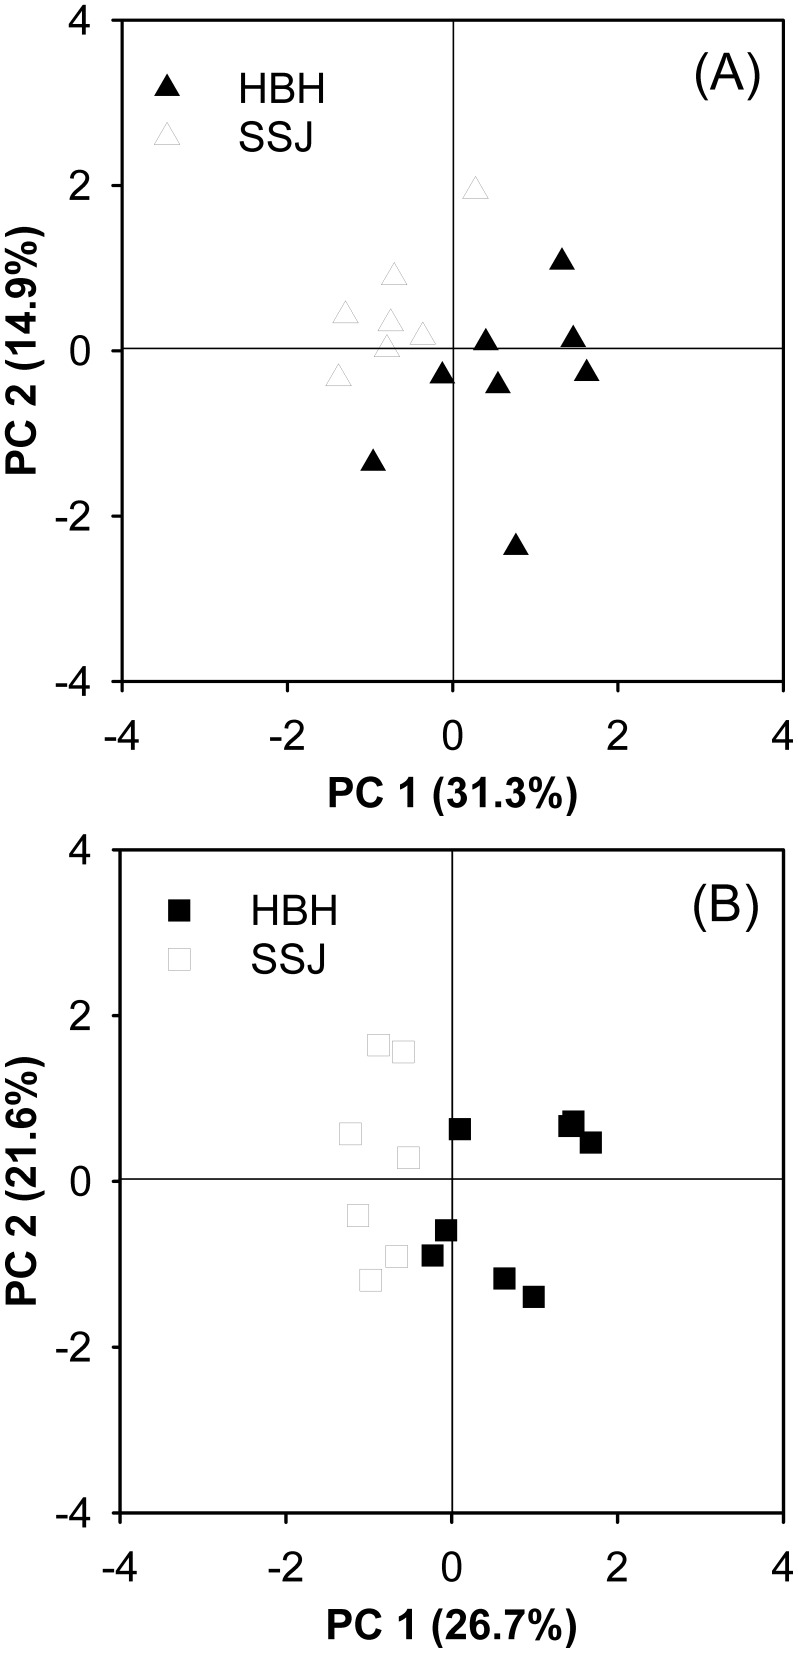
Visualization of the lipid profile differences in the corals.The score plot of principal component analysis, which showed distinguishable glycerophosphocholine profiles between the corals (Seriatopora caliendrum) inhabiting the upwelling (Houbibu, HBH) and control (Siashuiku, SSJ) regions in the tip (A) and stalk (B) portions of the tissue.